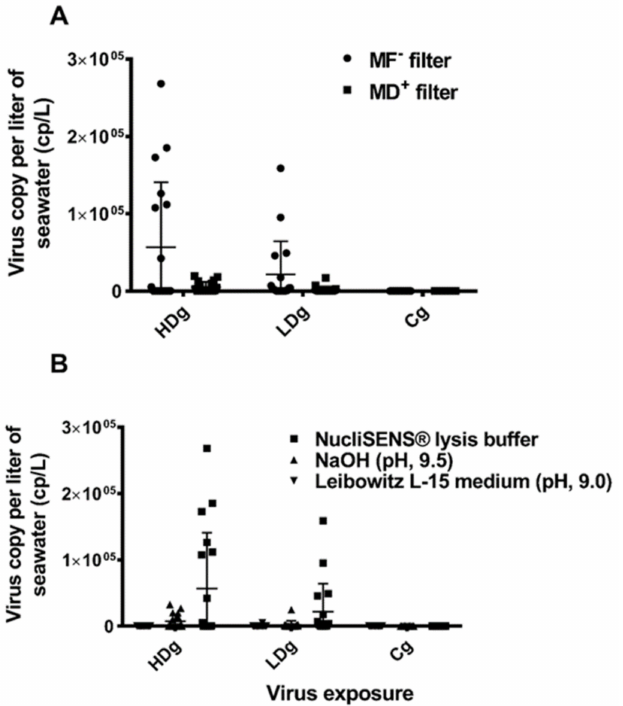
Figure 6. Comparison of the performance of the different buffers and filters used in concentration and detection of infectious salmon anemia virus RNA from 1 L seawater collected from HDg, LDg ISAV exposed individuals, and negative control Cg individual. ( A ) One liter of seawater was collected from HDg, LDg ISAV exposed tanks and negative control Cg tanks was concentrated with electronegative charged nitrocellulose MF hydrophilic membrane filter and electropositive charged 1 MDS Zeta Plus ® Virosorb ® membrane filter. Samples were eluted with NucliSENS ® lysis buffer and ISAV RNA in the seawater sample was measured by RT-ddPCR. Bars show the average detection at different time points (DPC), n = 18. ( B ) One liter of seawater was collected from HDg, LDg ISAV exposed tanks, and negative control Cg tanks were concentrated with electronegative charged nitrocellulose. MF hydrophilic membrane filter was eluted with NucliSENS ® lysis buffer, 1 mM NaOH pH 9.5 buffer, and L-15 medium + 2% FBS (pH 9.0), respectively. ISAV RNA in seawater samples was measured by RT-ddPCR. Bars show the average detection at different time points (DPC), n =